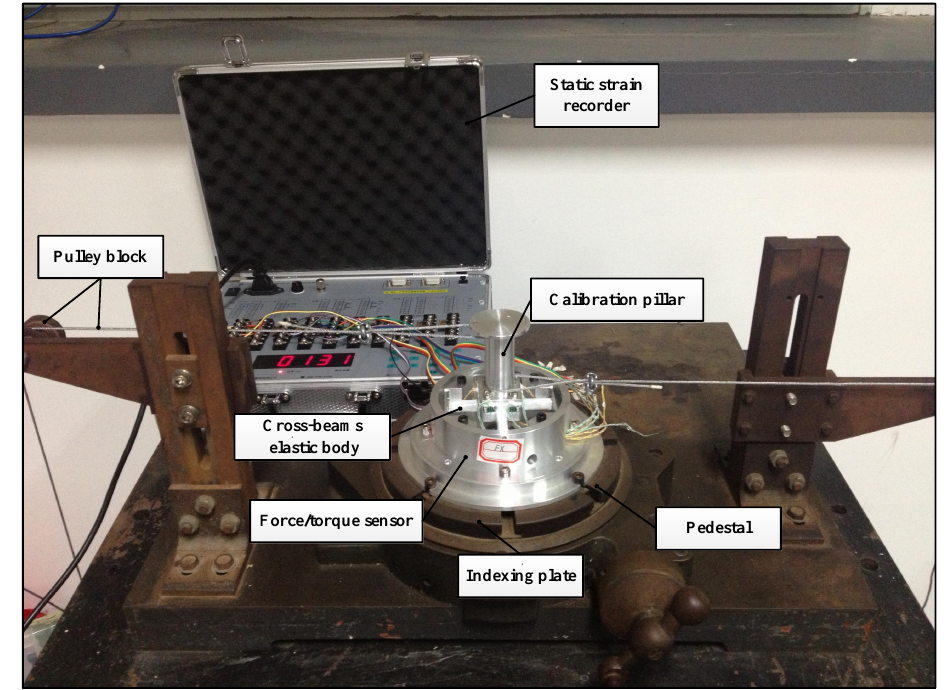
Figure 12. The calibration experiment